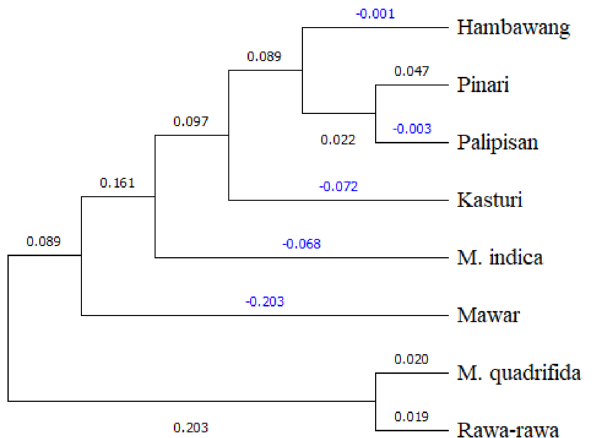
Figure 3. Dendrogram for UPGMA analysis in four M. casturi hybrids and four closely related species using 14 microsatellite